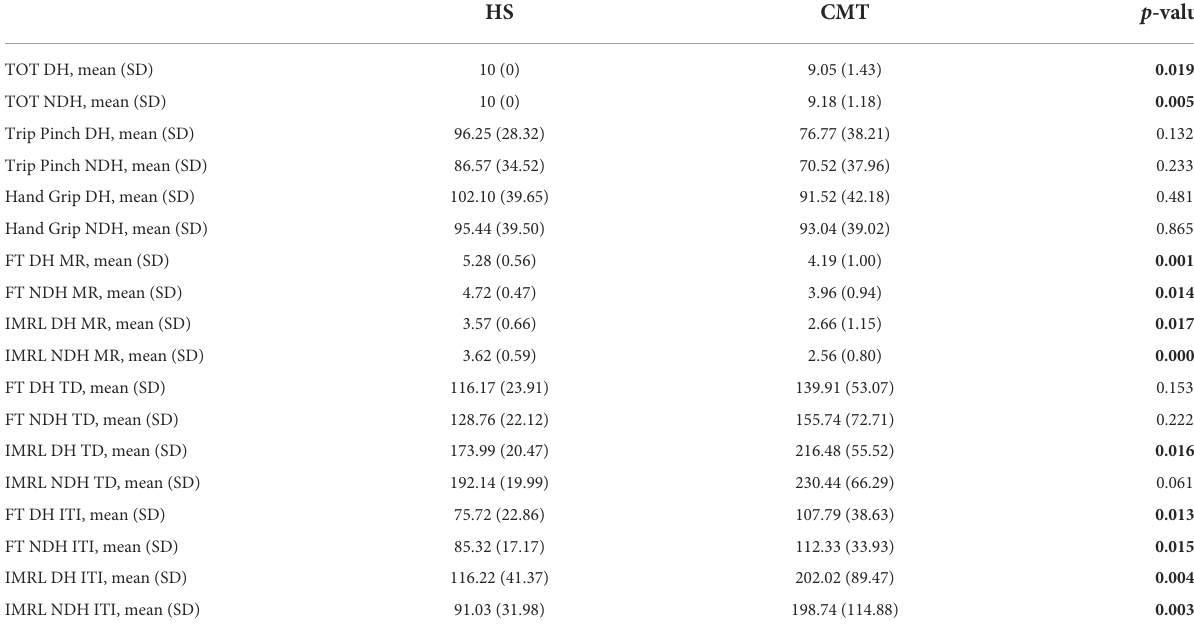
TABLE 2 CMT performances compared to HS in both clinical and instrumental